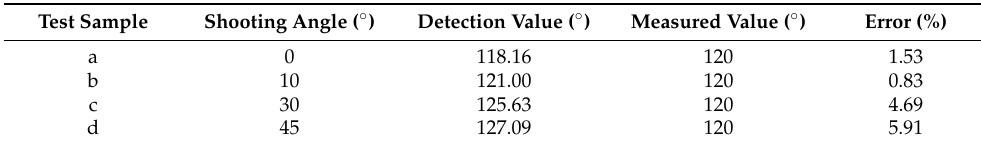
Figure 10. Identification results of bolt loosening under different shooting angles: ( a ) 0° of tilt; ( b ) 10° of tilt; ( c ) 30° of tilt; ( d ) 45° of tilt. Table 6. Experimental data analysis of bolt loosening under different shooting angles.